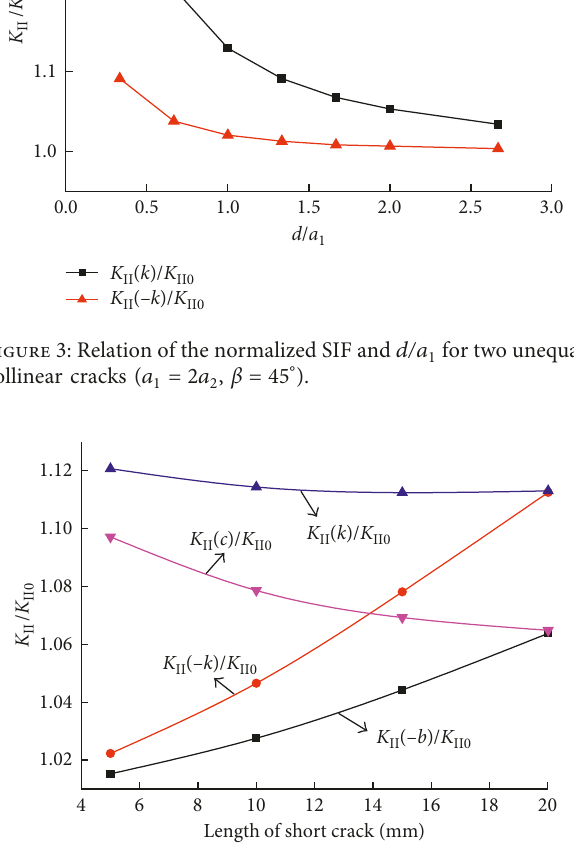
Figure 4: Relation of the normalized SIF and crack length for